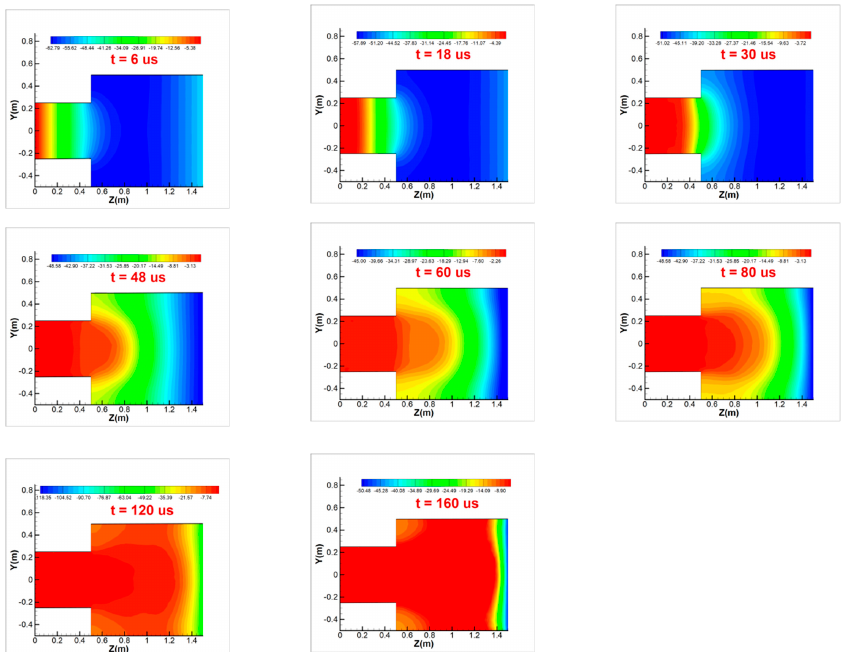
Figure 6. Potential distribution at different times on the x = 0 plane.